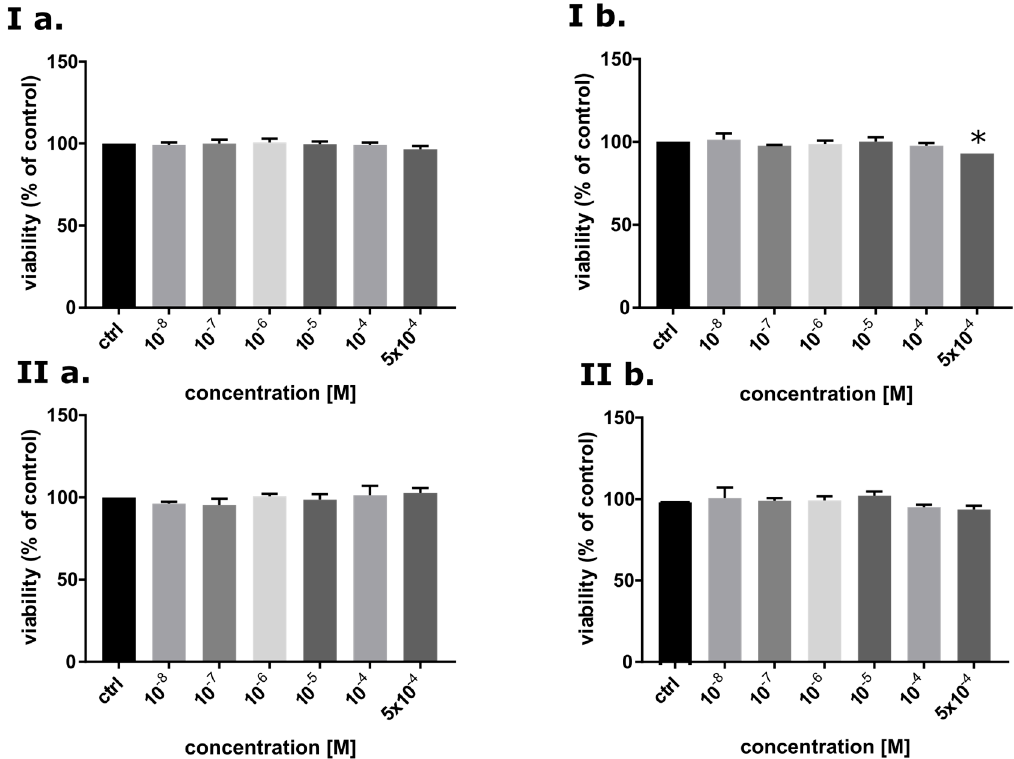
Figure 7. The viability of MCF-7 ( I ) and HDFa ( II ) cells after 24 ( a ) and 48 h treatment ( b ) with BrSdU in a range of concentrations from 0 to 5 · 10 − 4 M. Results are shown as mean ± SD of three independent experiments performed in triplicate. *statistically significant difference is present between treated culture compared with control (untreated